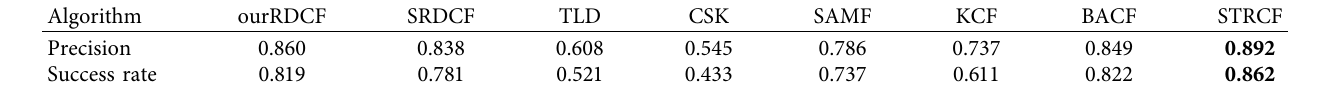
Table 2: Overall performance evaluation table of six algorithms.